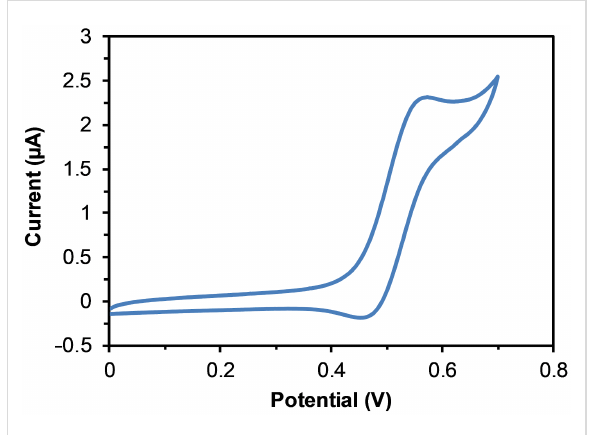
Figure 6: Cyclic voltammogram of ferrocene rotaxane 1a (0.67 mM) in CH 2 Cl 2 /CH 3 CN 1:5 (TBAPF 6 0.10 M, scan rate = 10 mV/s).